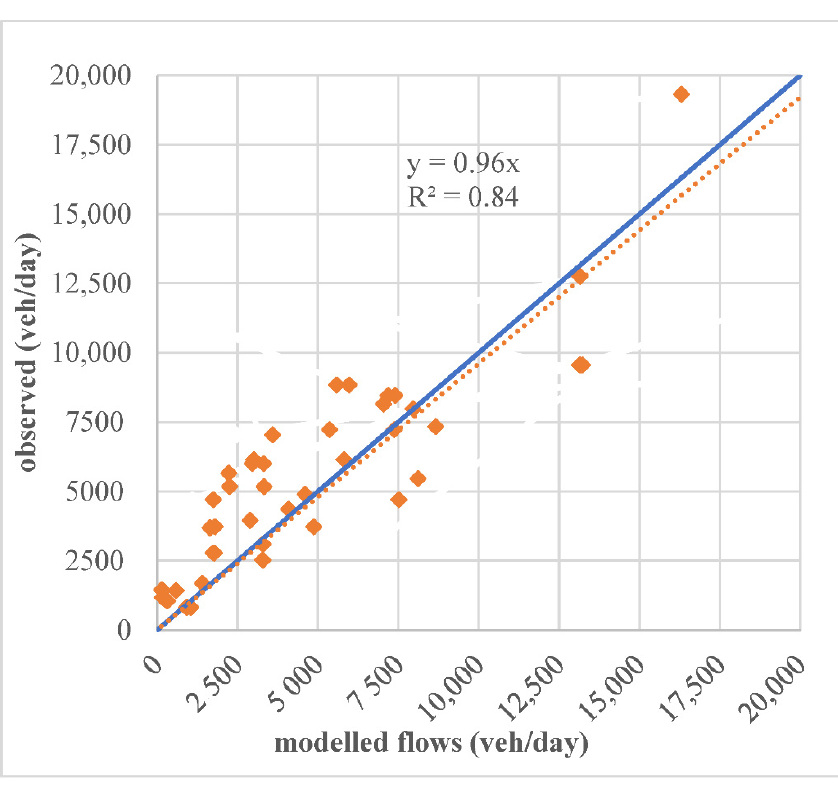
Figure 8. Comparison between revealed and modelled road link flows.